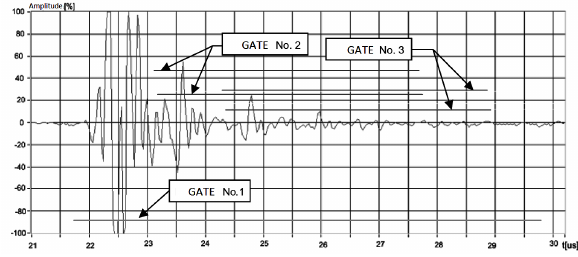
Figure 5: Example of the measurement signal with characteristic